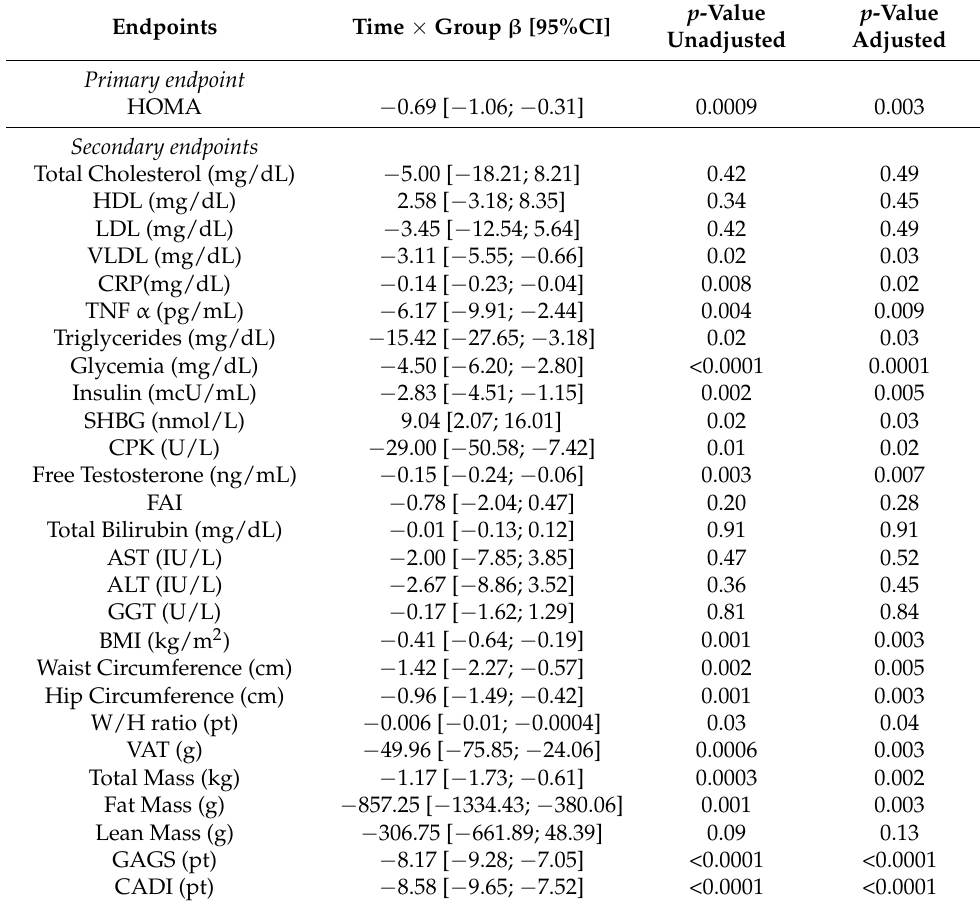
Table 7. Estimate ( β ), Standard Error, and p -value of the treatment effect on the primary and secondary endpoints, evaluated as difference between pre- and post-treatment, using a linear mixed